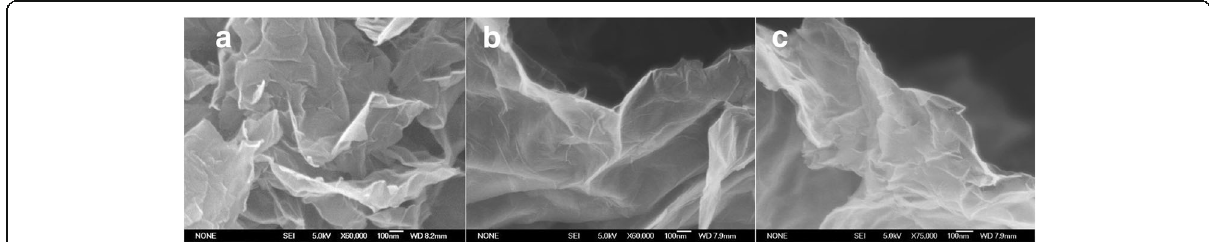
Fig. 2 The SEM image of a TRG, b TRGS, and c TRGSE